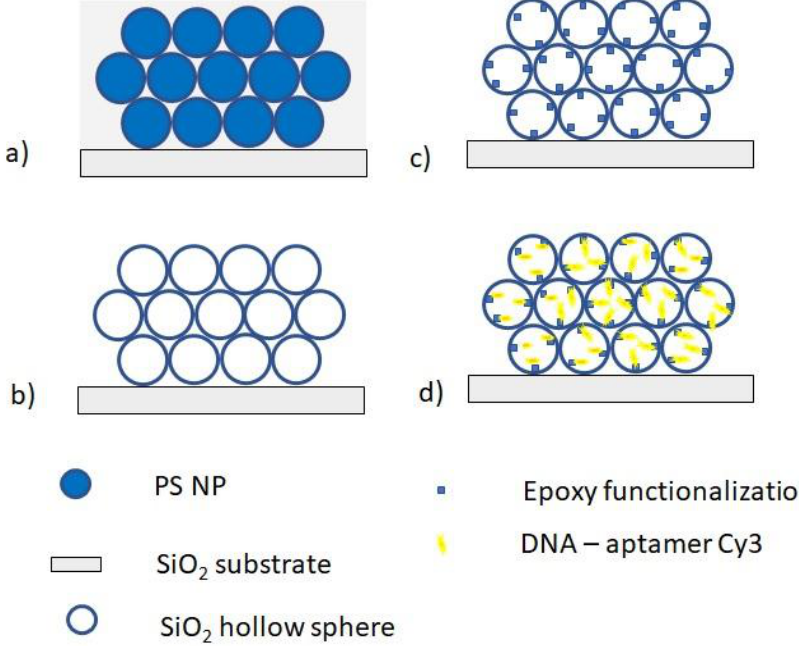
Figure 1. Sketch of the fabrication process for the realization of inverse silica opal and its functionalization with DNA-aptamer Cy3: ( a ) deposition of colloidal crystal film on the substrate, ( b ) calcinations of polystyrene template, ( c ) epoxy-functionalization of the colloidal film, ( d ) DNA-aptamer immobilization.